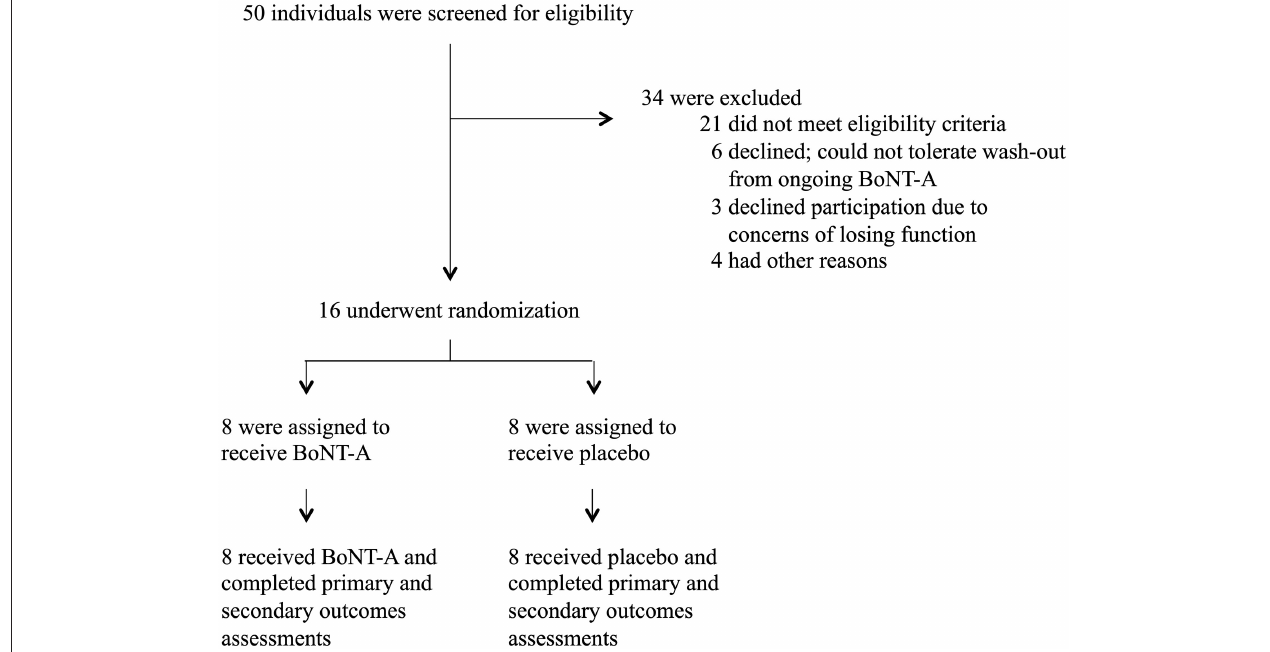
FIGURE 1 | Study patient flowchart. BoNT-A, botulinum toxin-A.